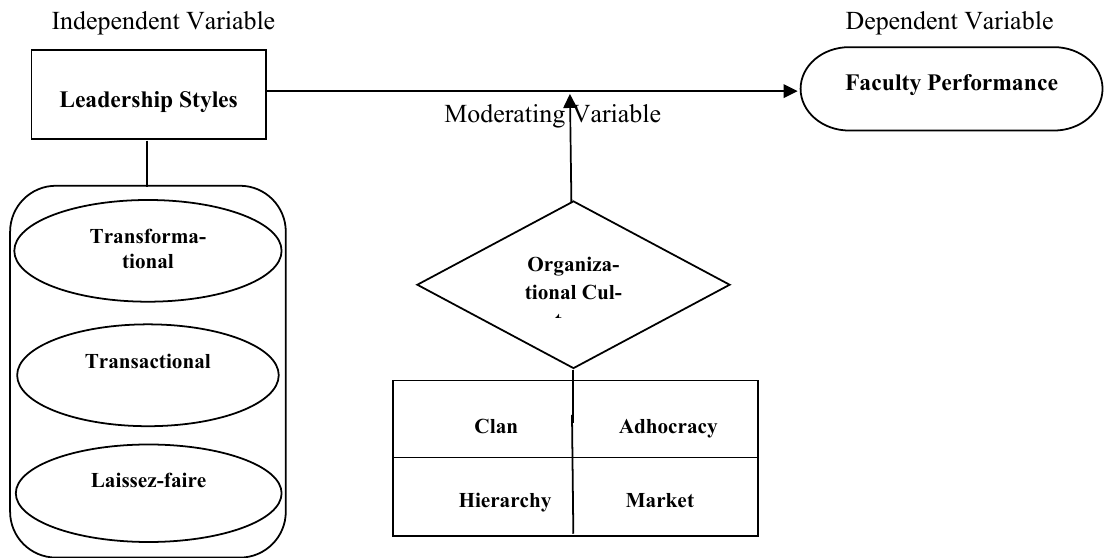
Fig 1. Conceptual